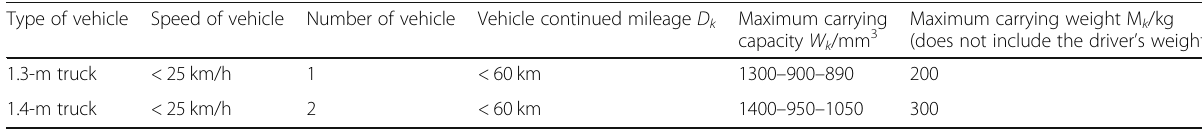
Table 5 The vehicle